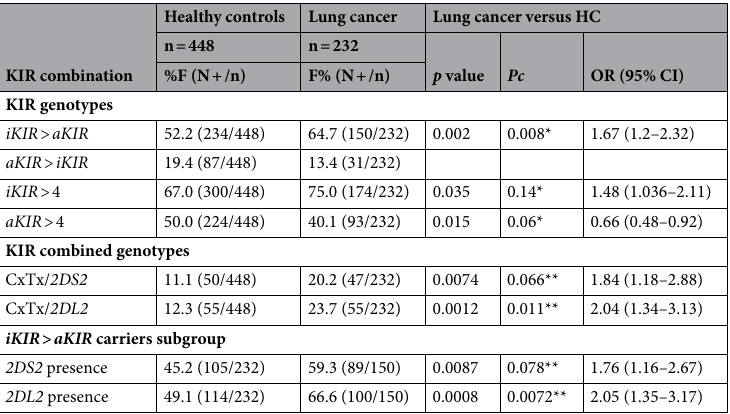
Table 5. Carrier frequency of various susceptibility-related factor combinations among patients with lung cancer and healthy controls. N + number of individuals positive for the gene, n number of individuals tested for the gene, HC healthy control, OR odds ratio, CI confidence interval. p < 0.05: statistically significant; based on two-tailed Fisher’s exact test; Pc : corrected p values, Pc* : correction factor = 4, Pc** : correction factor =